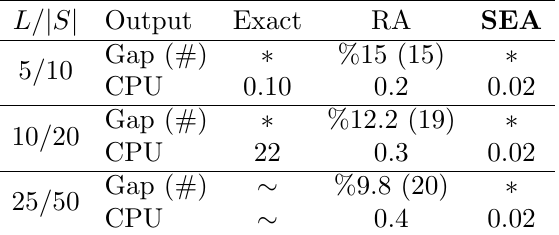
Table 8. Comparison of solution ap- proaches when ǫ = 0 .